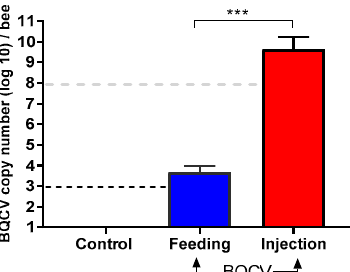
Figure 2. Absolute quantification (mean ± SD) of BQCV per adult honey bee at 10 days post inoculation. Bees ( n = 8 bees per treatment) either injected with one µ L inoculum containing 10 8 BQCV or fed 10 µ L of sugar syrup containing 10 8 BQCV. Controls received the same treatments devoid of virus. There was a significant di ff erence in BQCV load (genome equivalents, log 10 -transformed) between fed and injected bees (Student’s t -test, *** p < 0.001). Black dashed line indicates the threshold of detection while the gray dashed line indicates the initial dose of BQCV.